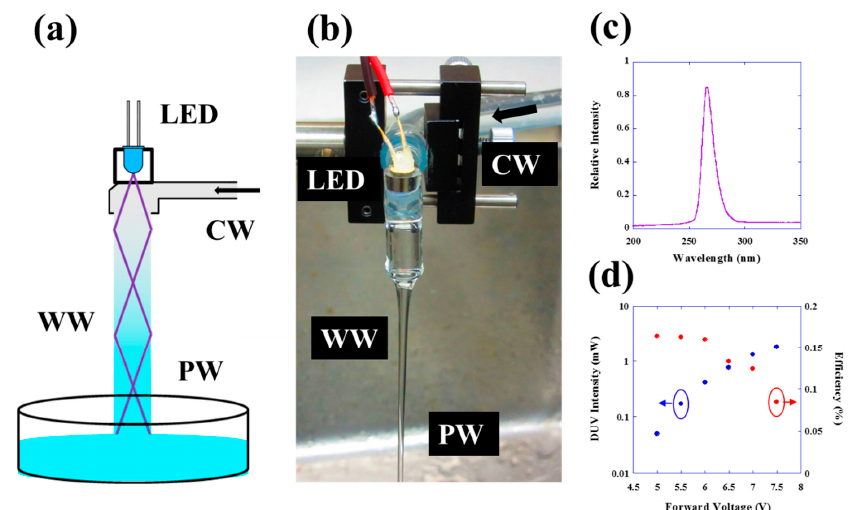
Figure 1. ( a ) Schematic and ( b ) photograph of the water waveguide purification system. Escherichia coli bacteria-contaminated water (CW) is supplied from a water tank reservoir, and the E. coli bacteria were disinfected at the water-waveguide (WW) region. To introduce the 265 nm emission from a deep-ultraviolet light-emitting diode (DUV-LED) into the WW region, we used a T-shaped glass tube. The length of the WW region was approximately 20 cm. After disinfection by the WW method, the degree of purification was analyzed by using 100 μ L of the solution from the purified water (PW) to coat nutrient broth agar plates. ( c ) Emission spectrum of the DUV-LED. The peak emission wavelength was 265 nm with a spectral width of 12 nm. ( d ) DUV intensity (blue circles) and wall-plug efficiency (red circles) as a function of forward voltage. DUV-LED intensity varied from 0.05 to 1.8 mW at a forward voltage of 5–7.5 V and a driving current of 20–300 mA. The efficiency gradually dropped beyond an applied voltage of 6 V (rated voltage) because of the thermal quenching effect.